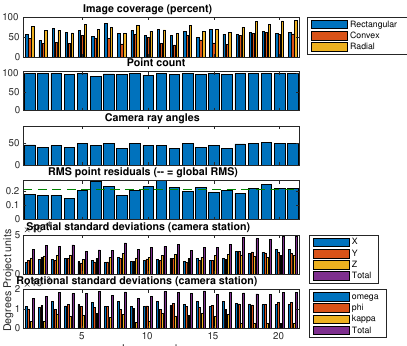
Figure 2: Image and external orientation statistics.